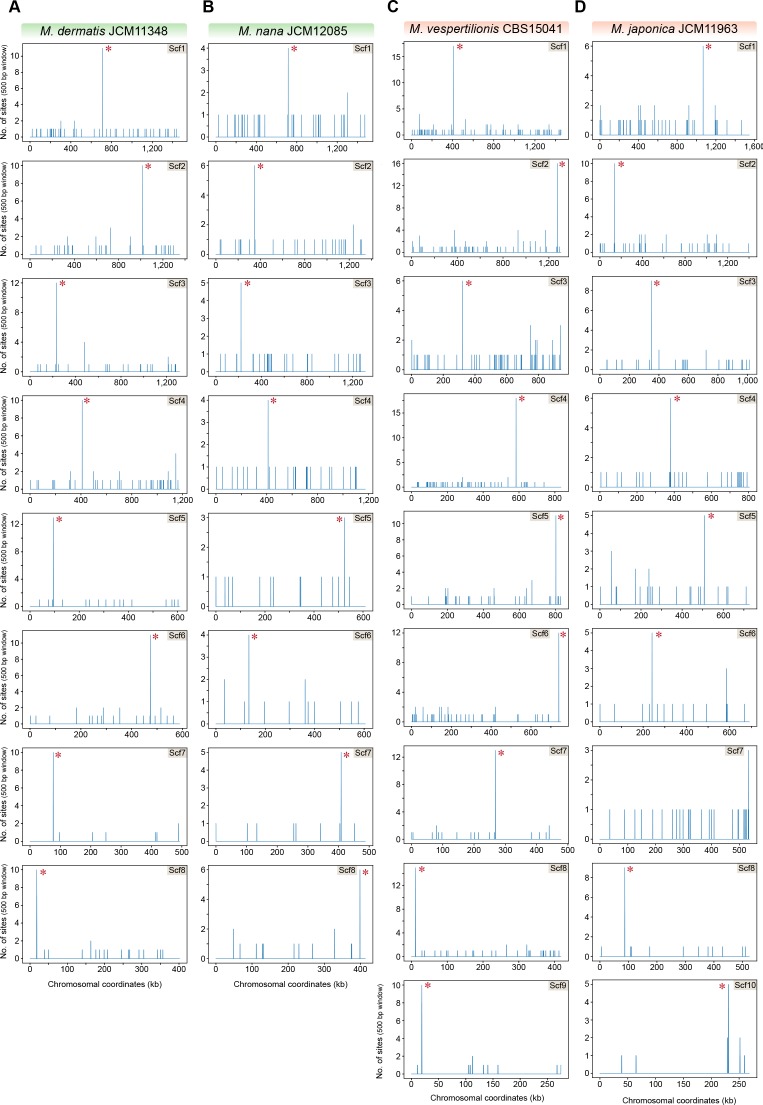
The 12-bp AT-rich motif is enriched at the putative centromeres of M. dermatis, M. nana, M. vespertilionis, and M. japonica.The genomes of M. dermatis, M. nana, M. vespertilionis, and M. japonica were scanned for matches to the 12-bp AT-rich motif using a 500 bp sliding window. Hit counts (y-axis) were plotted against the chromosomal coordinates (x-axis, in kb) for each of the above species. Red asterisks near the line corresponding to maximum enrichment in every chromosome or scaffold mark the regions predicted as centromeres in each species.